Question: Judging by this figure, is the value going up or going down?
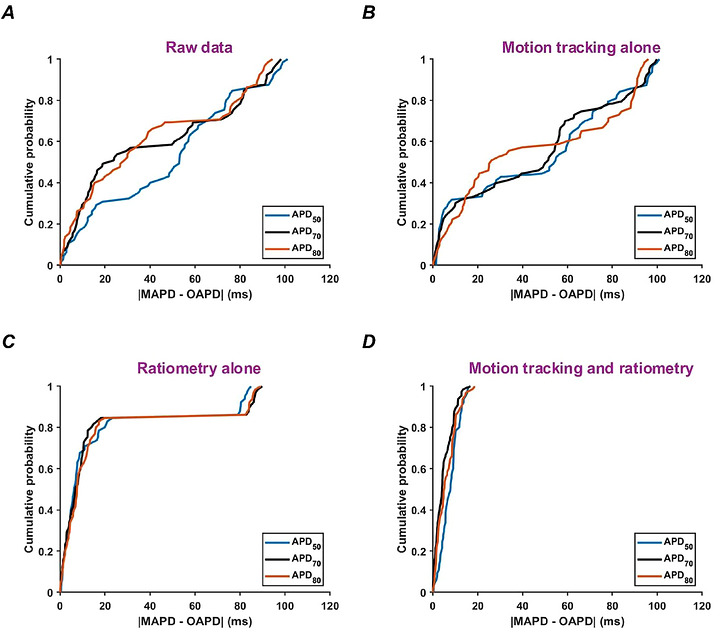
Answer: increasing